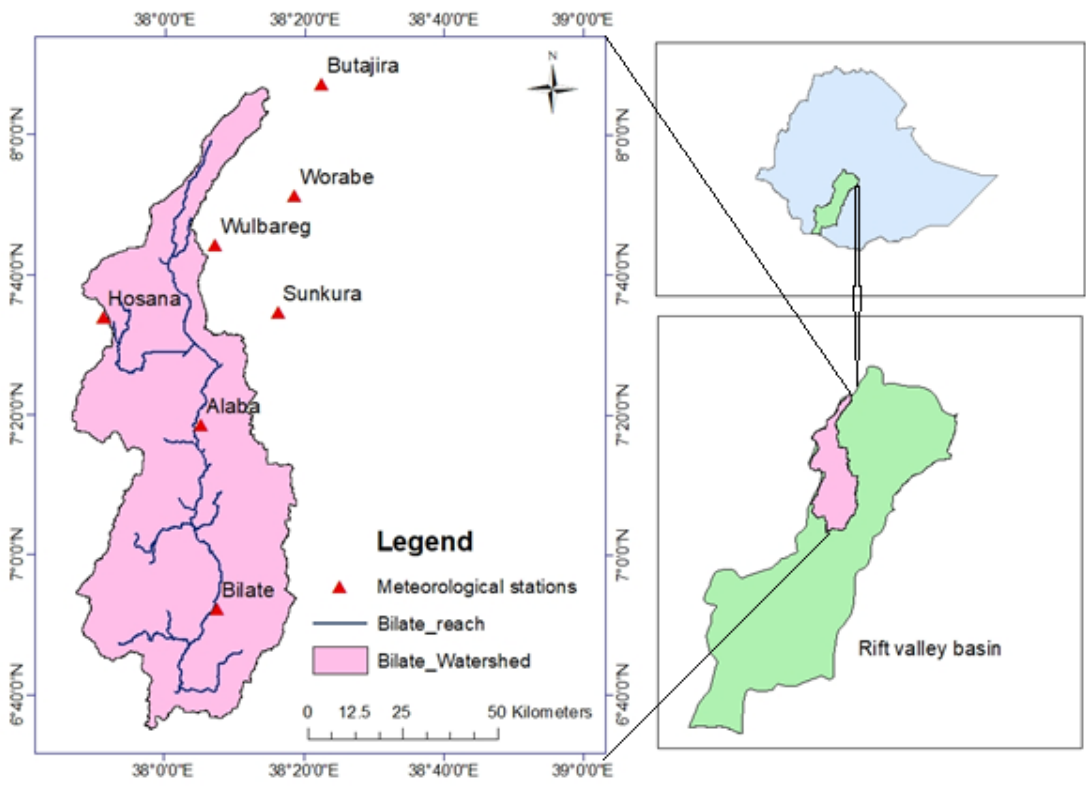
Figure 1. Location map of the study area .